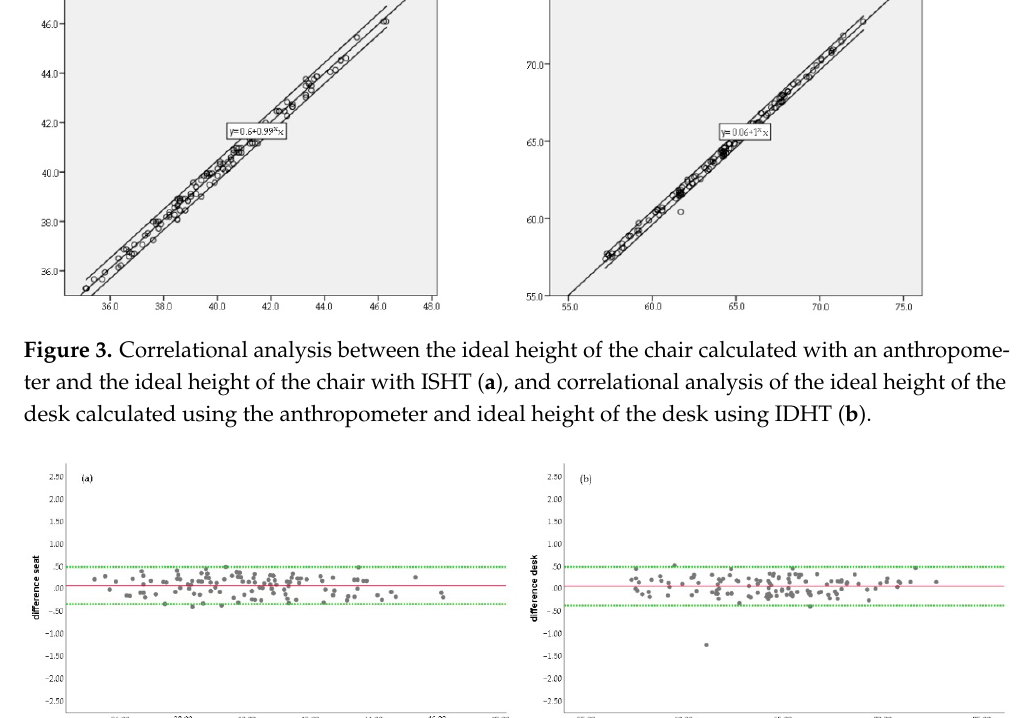
Figure 4. Bland and Altman test for ISHT ( a ) and IDHT ( b